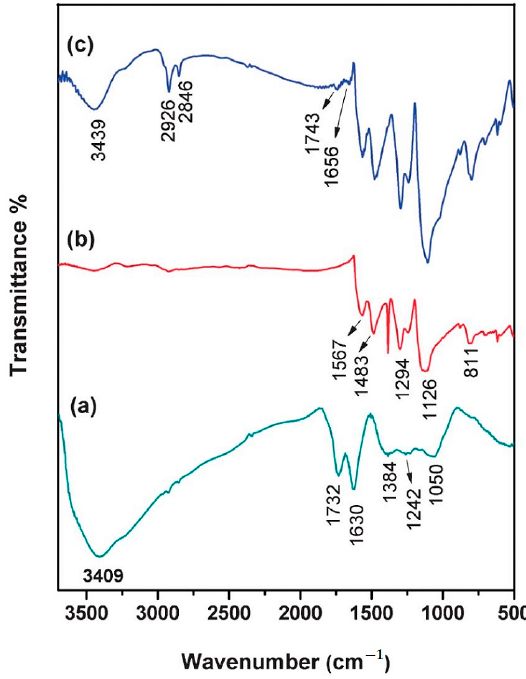
Figure 5. FTIR spectra of the compounds: ( a ) GO (green line); ( b ) PANI (red line); and ( c ) PANI-GO (blue line). Reproduced with the permission from ref. [63]; Copyright 2022 Springer.